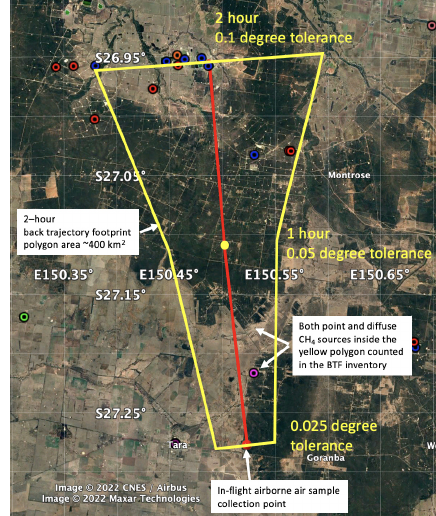
Figure A2. A representative BTF inventory polygon for IFAA sample 1817. The red line shows the 2h back trajectory determined using HYSPLIT. Refer to Fig. A1 for the point source colour key (image © Google Earth).